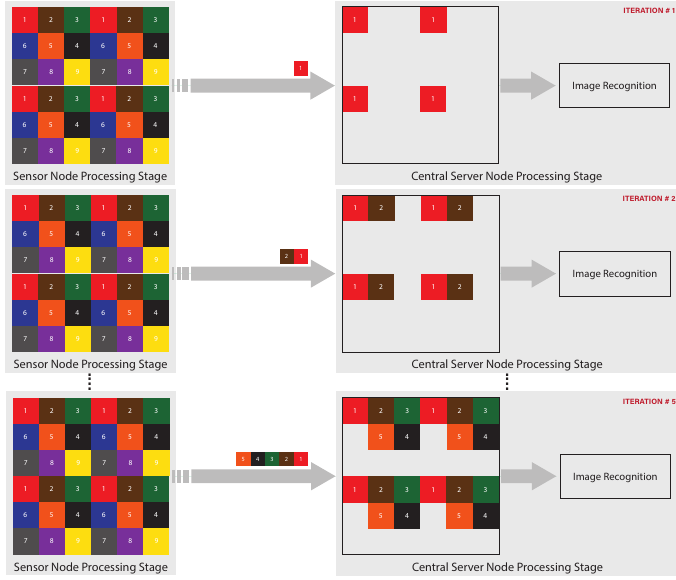
Figure 10. WVSN progressive image